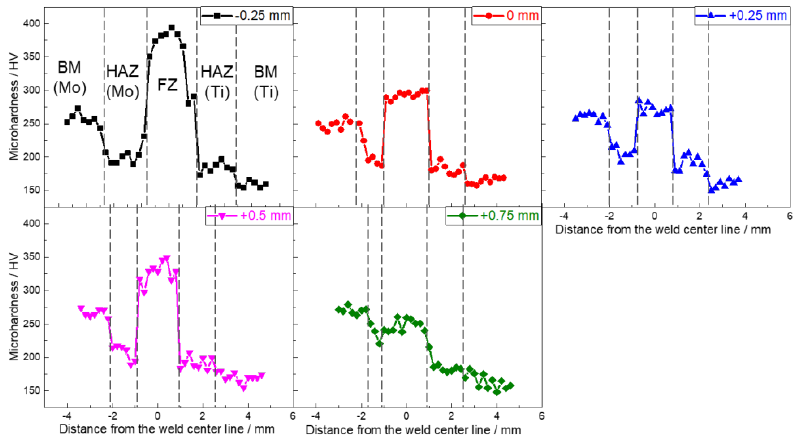
Figure 10. Effects of laser beam offset on microhardness distribution on the cross-sections of Mo/Ti joints.